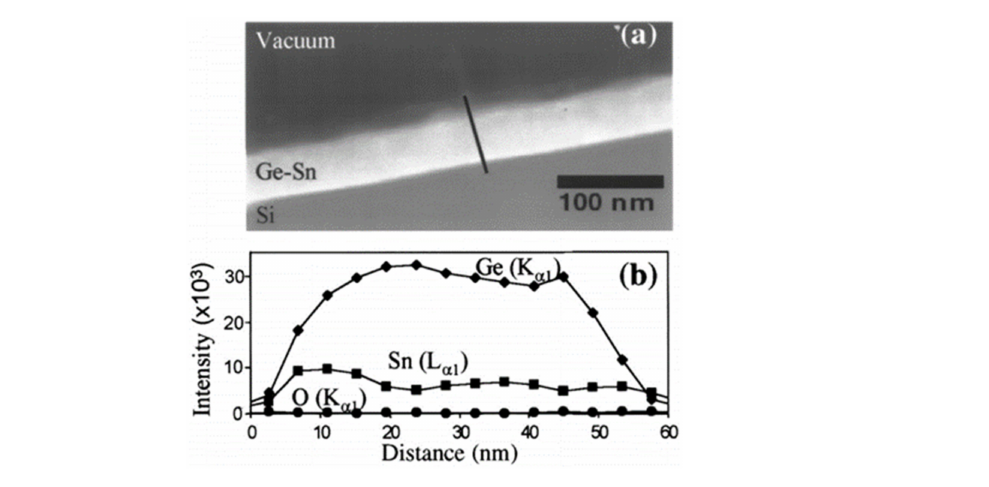
Figure 3. ( a ) Scanning transmission electron microscopy (STEM) image and ( b ) EDX cross-sectional profile of the GeSn with Sn contents of up to 25%. Reproduced with permission from [138], AIP Publishing, 2001.